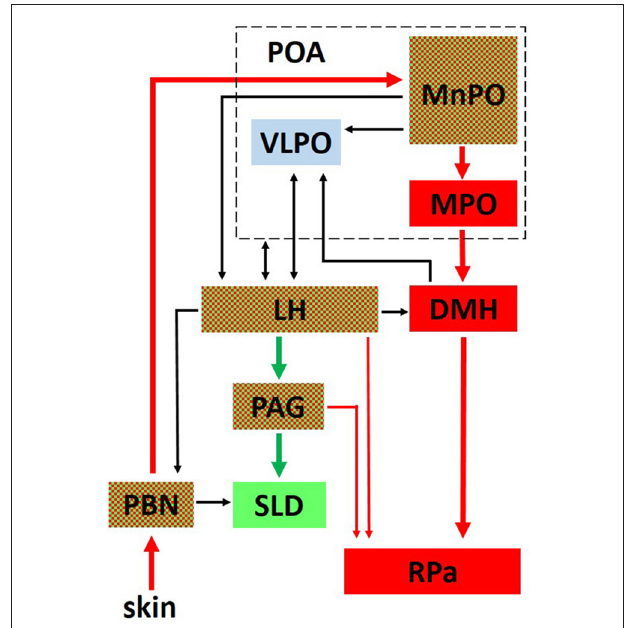
FIGURE 2 | The interplay between critical networks controlling REM sleep (green), thermoregulation (red) or both (checkered). Ambient temperature information from thermosensors in the skin is carried through the dorsal columns of the spinal cord to the parabrachial nucleus (PBN) where it is then relayed to the median preoptic nucleus (MnPO) in the preoptic area (POA). Both warm and cold sensitive neurons in the MnPO relay information to the medial preoptic nucleus (MPO) and to the dorsomedial hypothalamic nucleus (DMH). From there, a major thermoregulatory pathway involves the connection to the raphe pallidus (RPa) which is a major output pathway for the control of brown adipose tissue (BAT). Not shown in the figure is a direct pathway from the MnPO and MPO to the RPa for the output control of vasomotor thermoregulatory responses (137). The LH receives either direct or indirect input from the POA related to sleep and thermoregulatory centers and plays an important role in REM sleep control through its descending connections to the ventrolateral periaqueductal gray (PAG) which projects to the sublaterodorsal tegmental nucleus (SLD) in the pons. Hcrt neurons in the LH send projections to the RPa and play an important role in modulating thermoregulatory control. Reprinted with permission from Cerri et al.